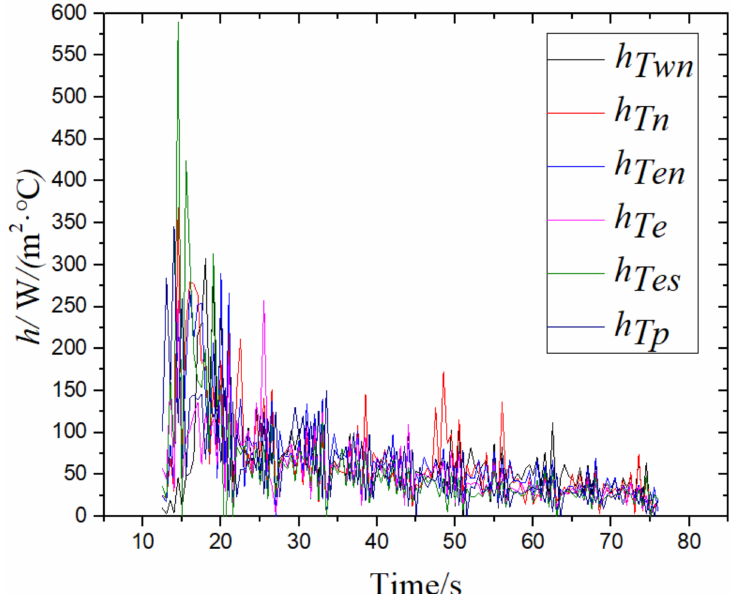
Figure 8. The change of the convection heat transfer coefficient with time at different points on the surface.